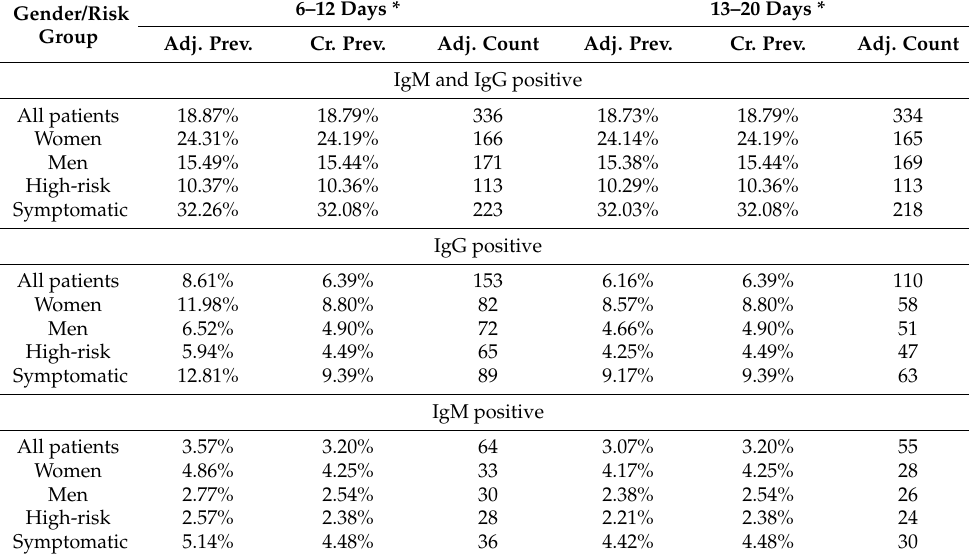
Table 3. Calculation of adjusted seropositivity in men and women using open data on sensitivity and